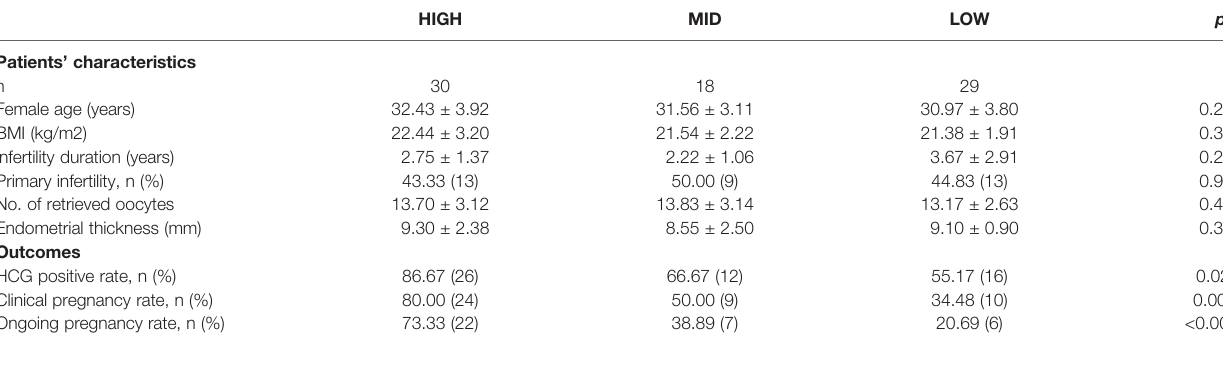
TABLE 3 | Association of GM-CSF concentration in FET-SBCM with the pregnancy outcome.